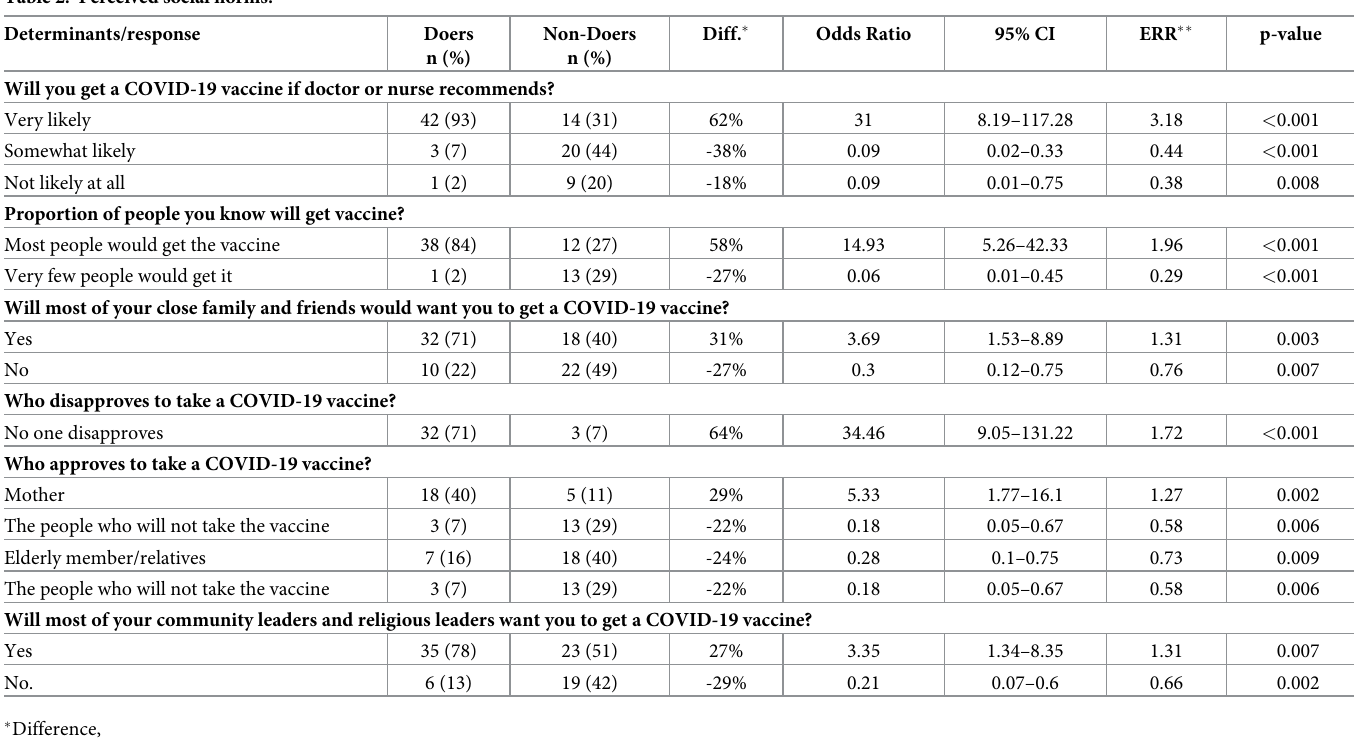
Table 2. Perceived social